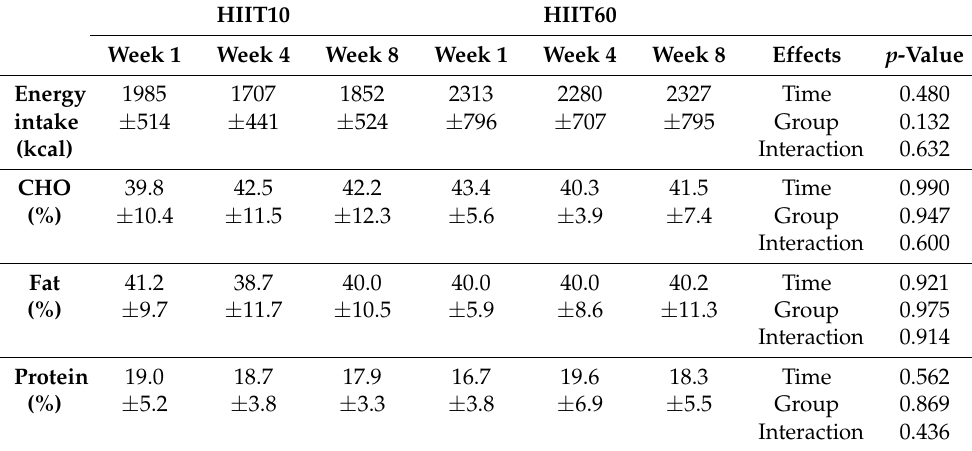
Table 1. Energy and macronutrient intake at the start (week 1), middle (week 4) and last week (week 8) of the intervention for the two training groups (HIIT10 and HIIT60).